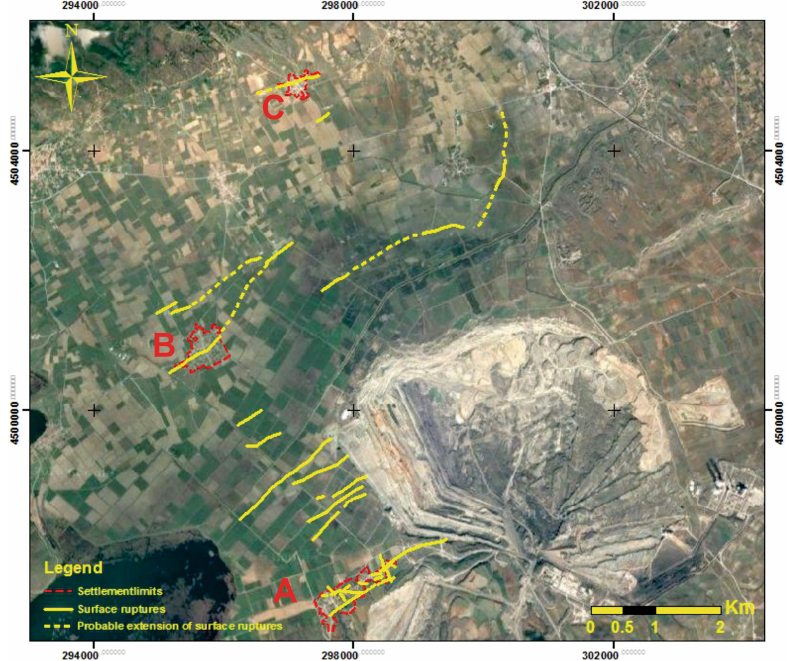
Figure 7. Intensive Distribution of the surface ruptures at the Amyntaio basin. A. Anargiroi, B. Valtonera and C. Fanos villages (Tzampoglou and Loupasakis,